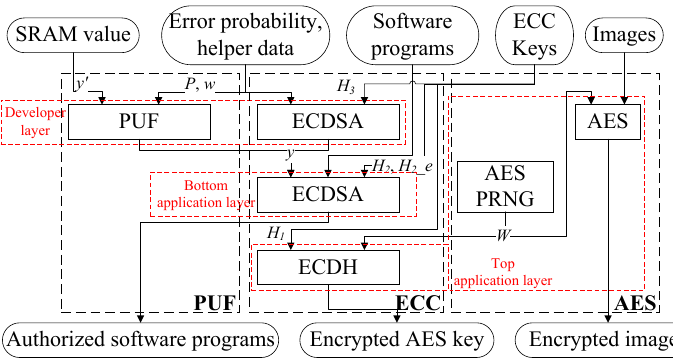
Figure 7. Triple-hybrid encryption system